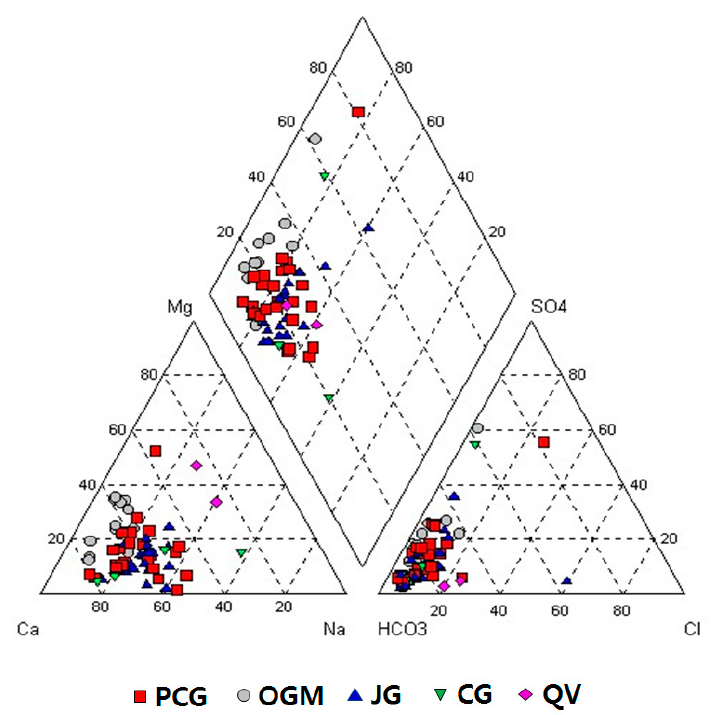
Figure 3. Water types plotted on the Piper diagram. PCG: Precambrian gneiss, OGM: Ogcheon metamorphic rocks, JG: Jurassic granite, CG: Cretaceous granite, QV: Quaternary Jeju Island volcanic rocks.